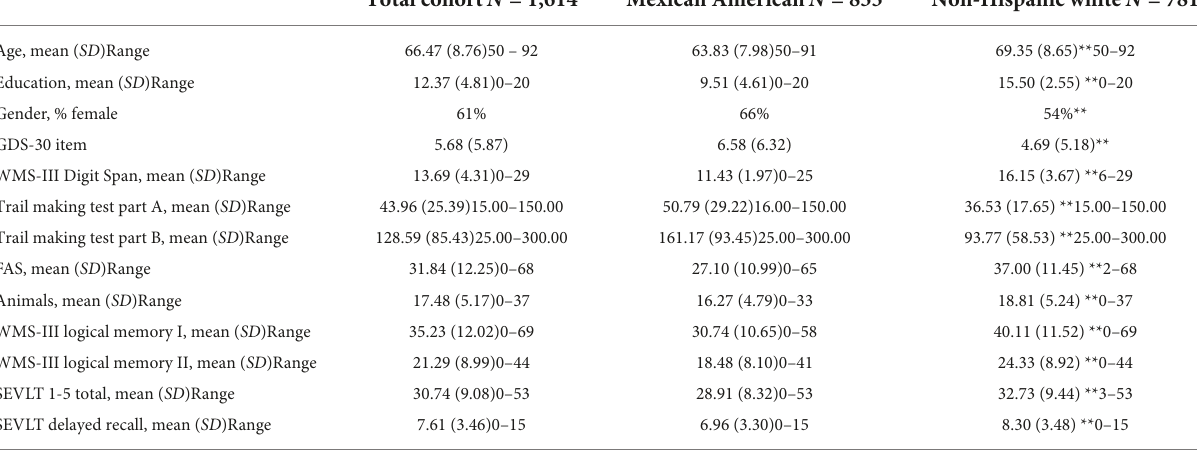
TABLE 1 Descriptive statistics of